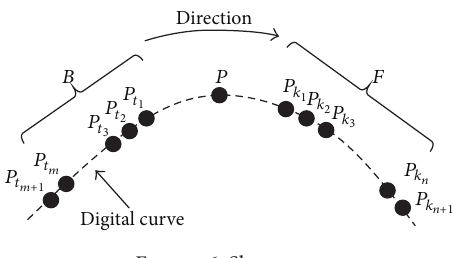
Figure 6: Sharpness.